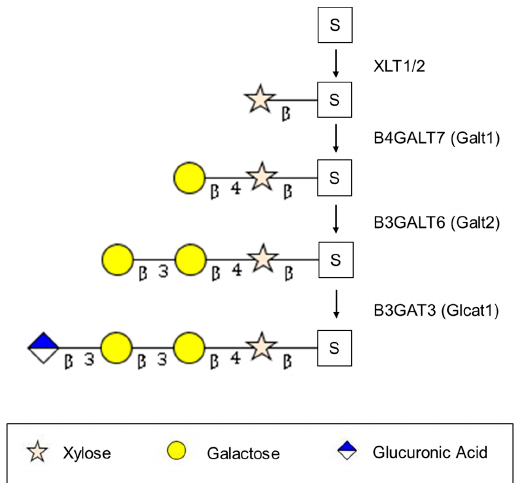
Figure 2. The initial step in the synthesis of the heparan sulfate proteoglycan (HSPG) linker is the linkage of xylose to a serine residue in the core protein. Subsequent linkages are catalyzed by the family sugar transferases as indicated in the text.